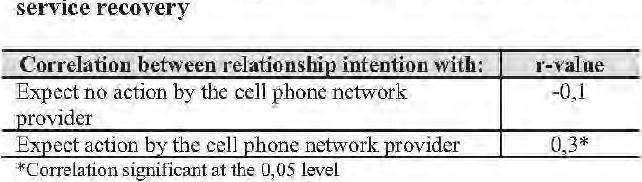
Table 3: Relationship intention and expectations